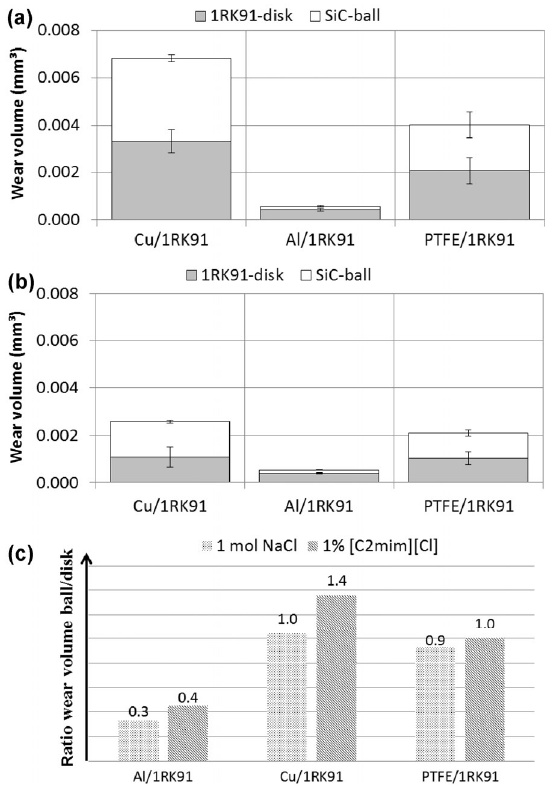
Fig. 4 Wear volumes of ball and disk after friction test with three different galvanic coupling elements (copper, aluminium and Polytetrafluoroethylene) in contact with steel 1RK91 disk using two different electrolytesafter tribotest (10 N, 20 Hz, RT, 1 mm, 1 h): (a) 1 molar NaCl solution; (b) 1% [C 2 mim][Cl]; (c) Ratio of wear volume of ball and